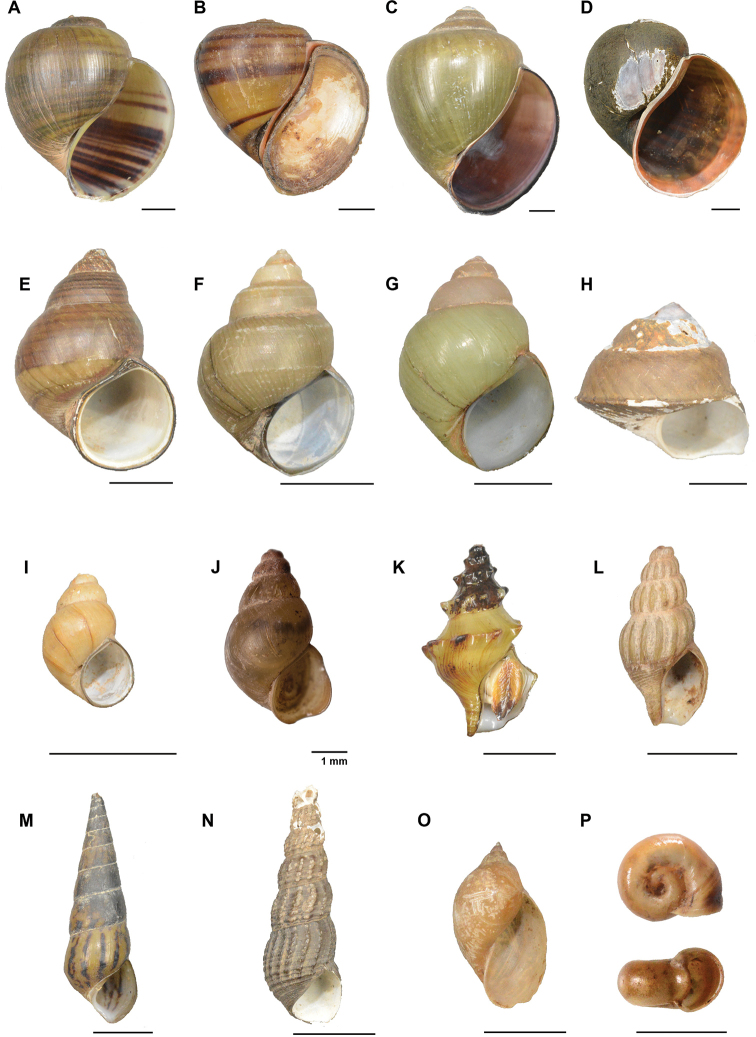
Freshwater gastropods of the Tonle Sap basin, Cambodia APila
gracilisBPila
pesmeiCPila
virescensDPomacea
maculataEFilopaludina
martensi
cambodjensisFIdiopoma
umbilicataGMekongia
ratteiHTrochotaia
trochoidesIBithynia
siamensis
goniomphalusJWattebledia
siamensisKAnentome
cambojiensisLAnentome
helenaMSulcospira
houseiNMelanoides
tuberculataOIndoplanorbis
exustus and PRadix
rubiginosa. Scale bars: 10 mm, unless stated otherwise. Photographs by TH Ng.